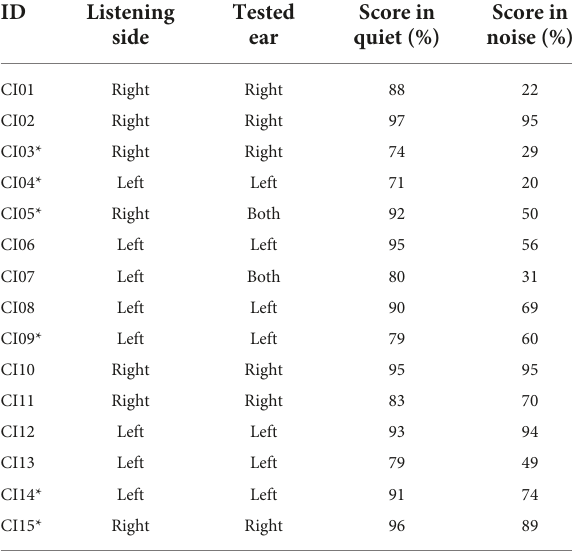
TABLE 2 AzBio performance of CI listeners in quiet and in noise (SNR + 5 dB) for the ear used during listening